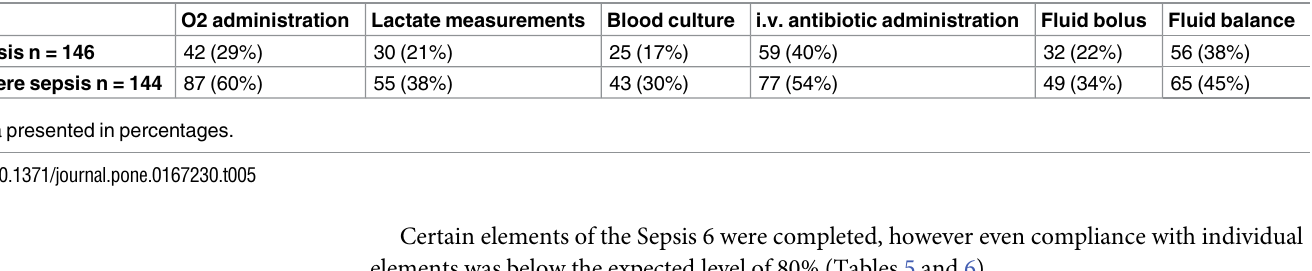
Table 5. Sepsis 6 bundle elements completed in sepsis and severesepsis patients